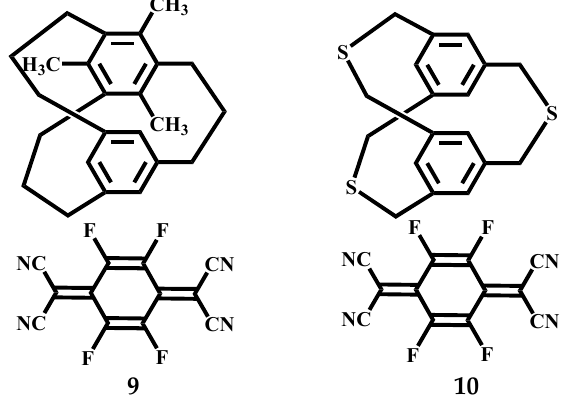
Figure 6. The structures of Me 3 [3 3 ]CP-, S 3 [3 3 ](1,3,5)CP- TCNQ-F4 complexes 9 and 10 .